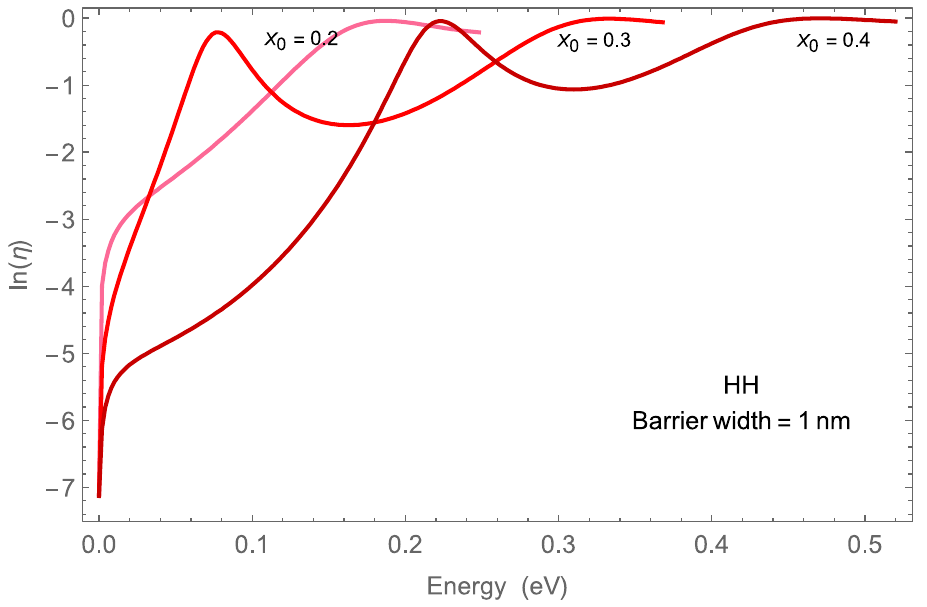
Figure 7. Logarithm of the transmission coefficient for HH as a function of energy for the double- barrier In x Ga 1 − x N/GaN parabolic quantum well structure with various x 0 at an applied bias of 0.8 V, and barrier width 1